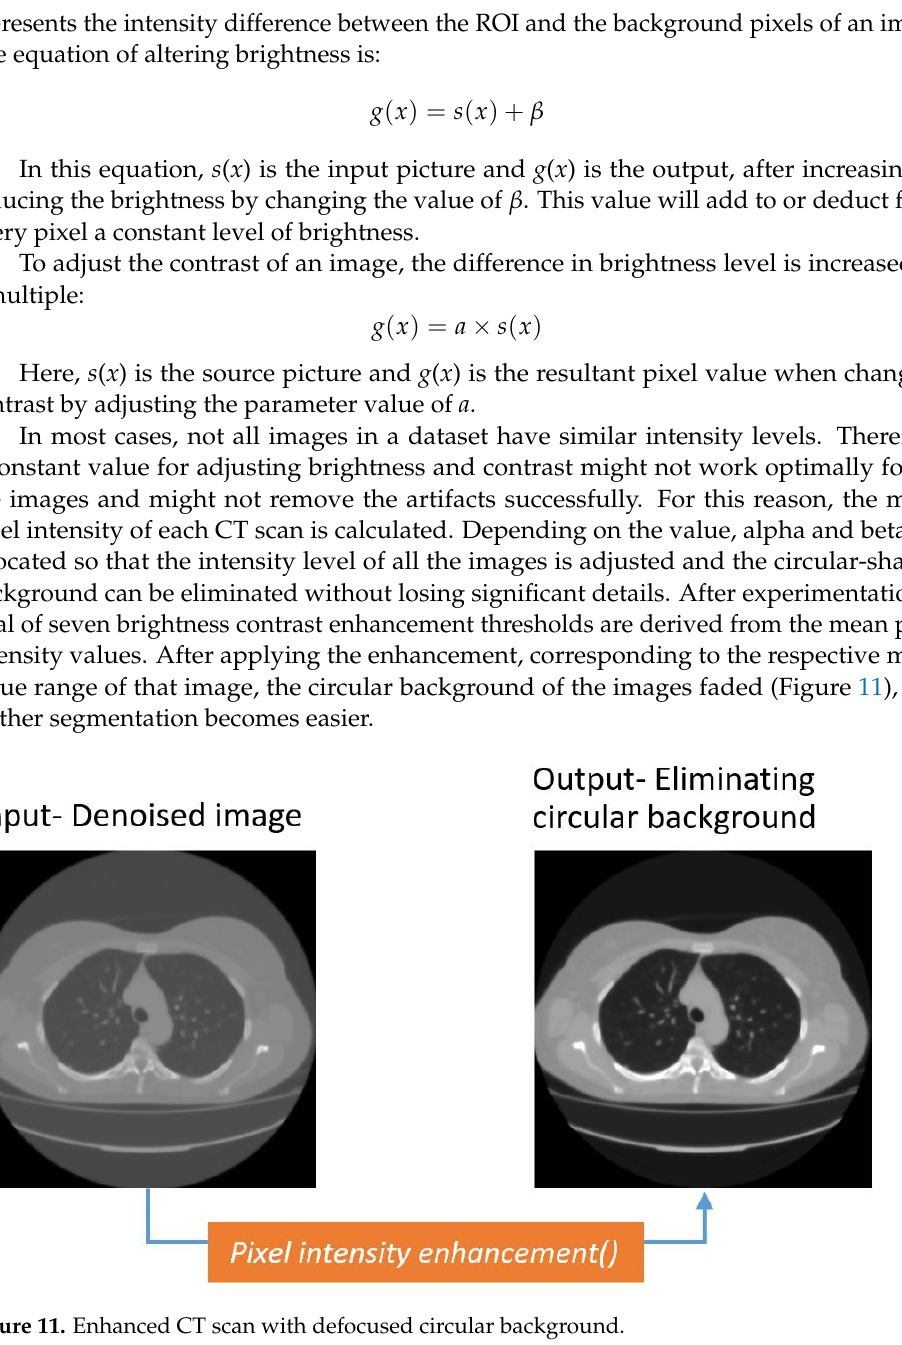
Figure 11. Enhanced CT scan with defocused circular background.